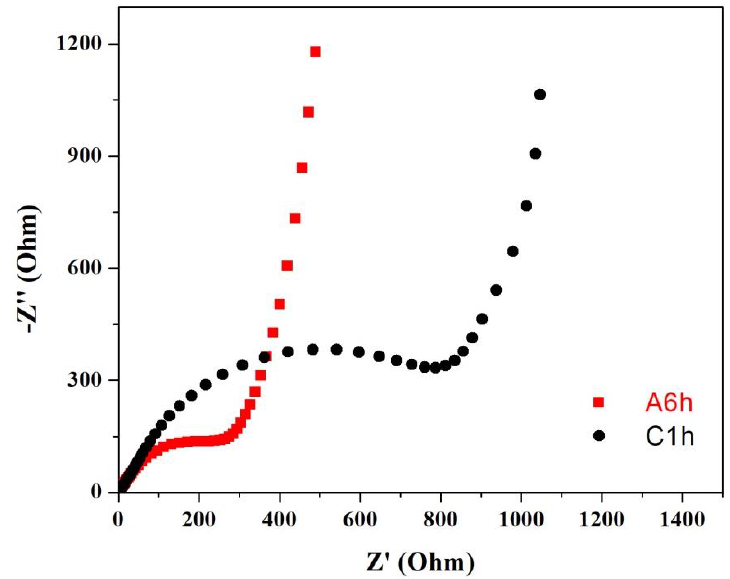
Figure 8. Nyquist plots of the amorphous and the crystalline Fe 2 O 3 electrodes.